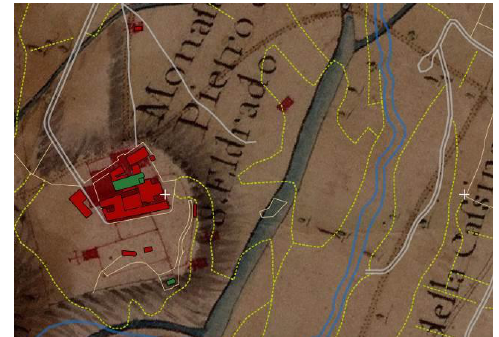
Figure 1. Old Cartography for the analysis of the Abbey’s territory superimposed to the regional technical map [The great map of the Susa Valley. AST, Court, Topographic maps and drawings, Topographic maps for A and B, “Susa 3”]